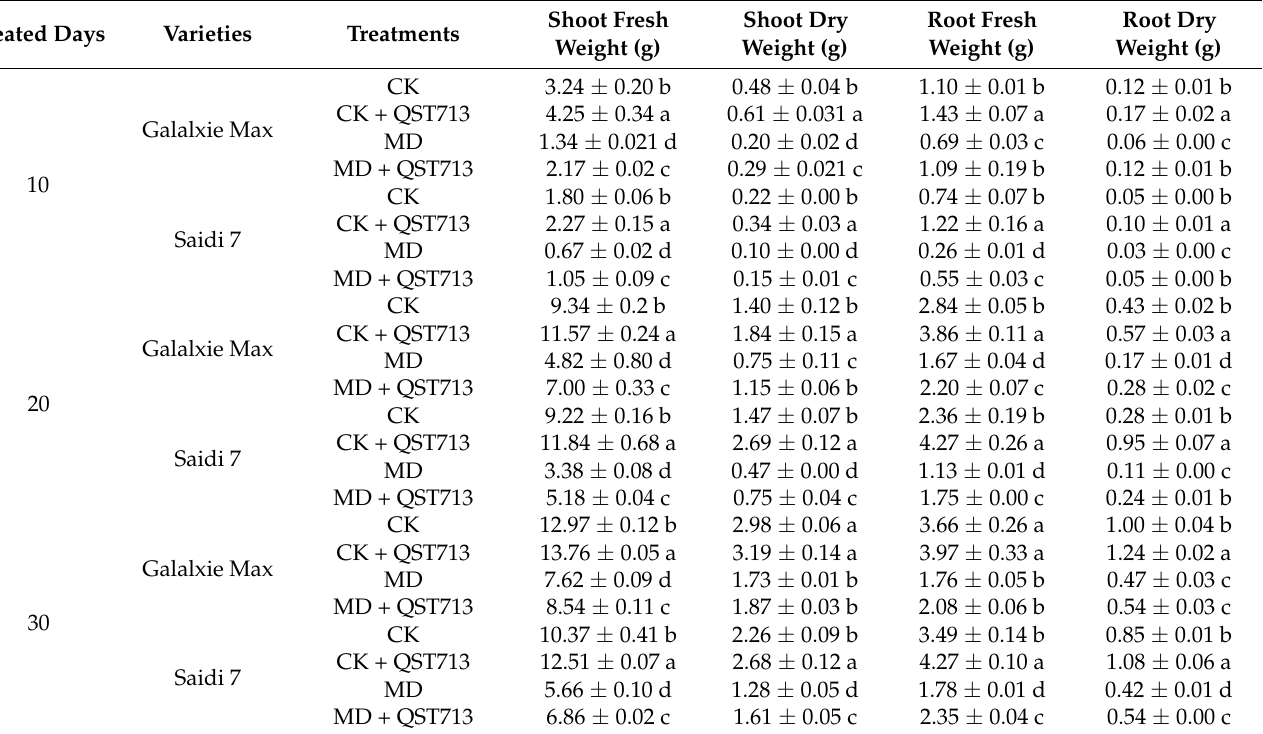
Table 1. Effect of drought stress and QST713 application on the biomass of alfalfa seedlings in two